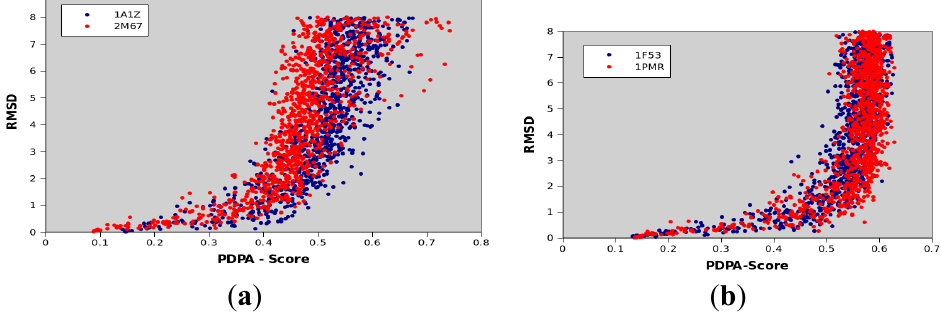
Figure 13. Sensitivity of 2D-PDPA analysis as a function of bb-rmsd when applied to ( a ) two unrelated a-proteins and ( b ) two unrelated b-proteins. Simulations included addition of ±0.5 Hz of uniformly distributed noise.